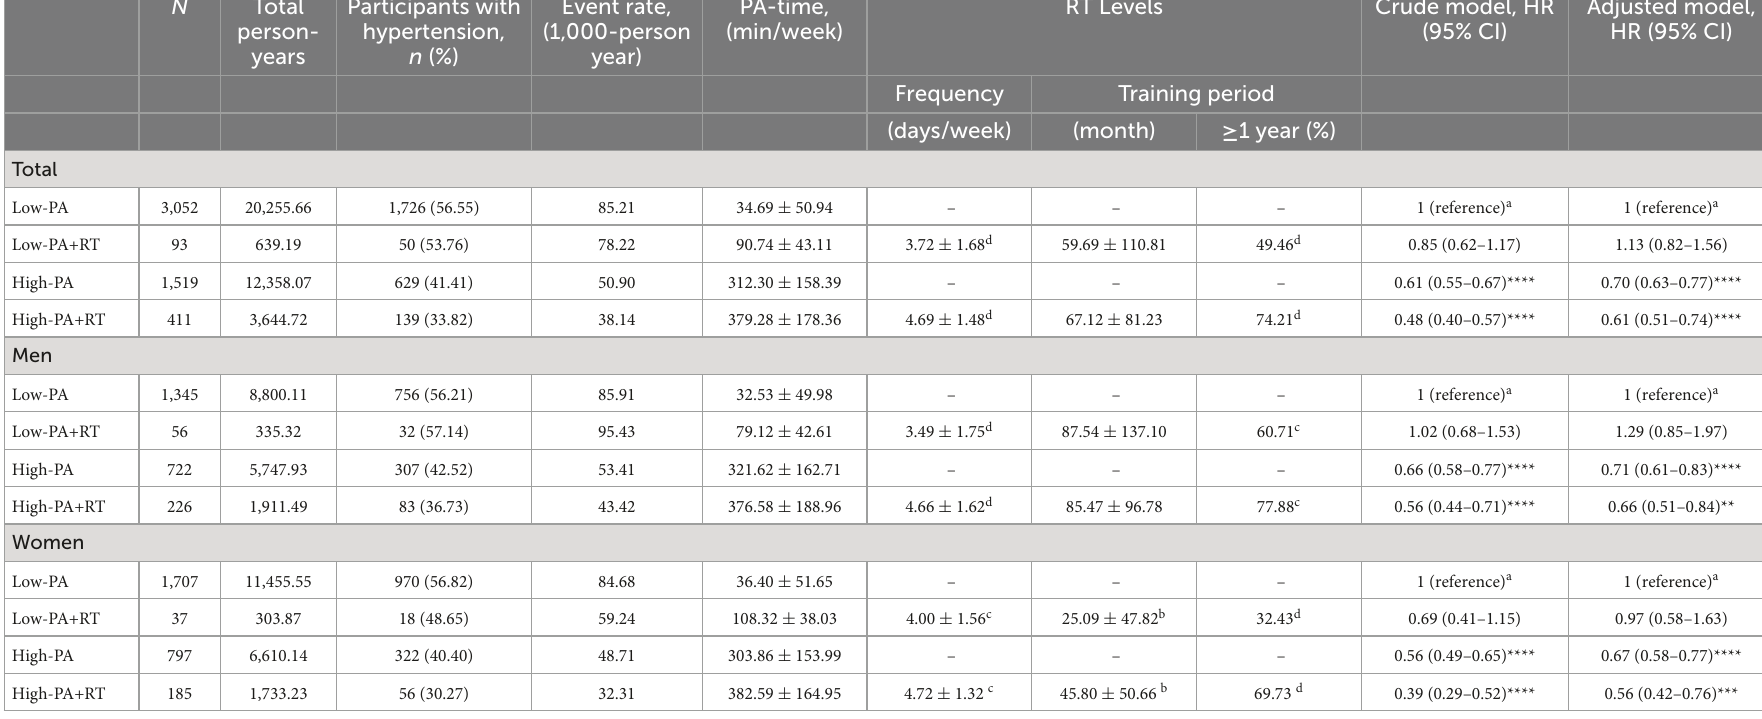
TABLE 3 Leisure-time physical activity (PA) level-, resistance training (RT) regularity-, and sex-stratified hazard ratios for incident